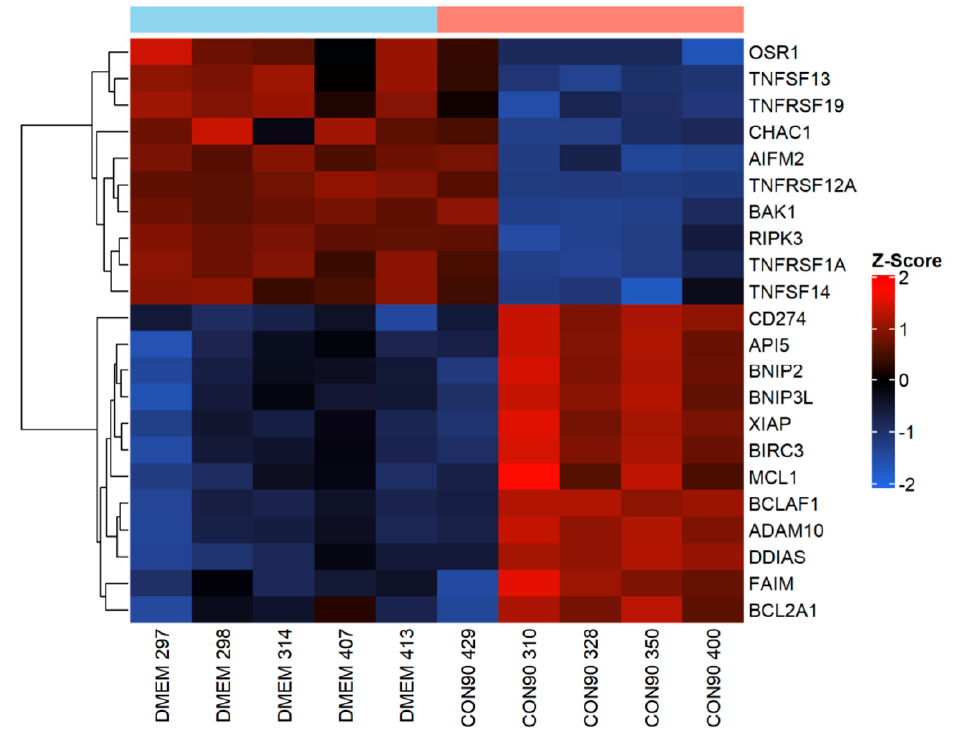
Figure 5. Expression of genes involved in apoptotic regulation in inguinal LN. Heatmap showing gene expression profile of apoptotic genes in ILN tissue from persistently infected and mock-infected animals. This heatmap was generated in the same manner as described in the legend to Figure